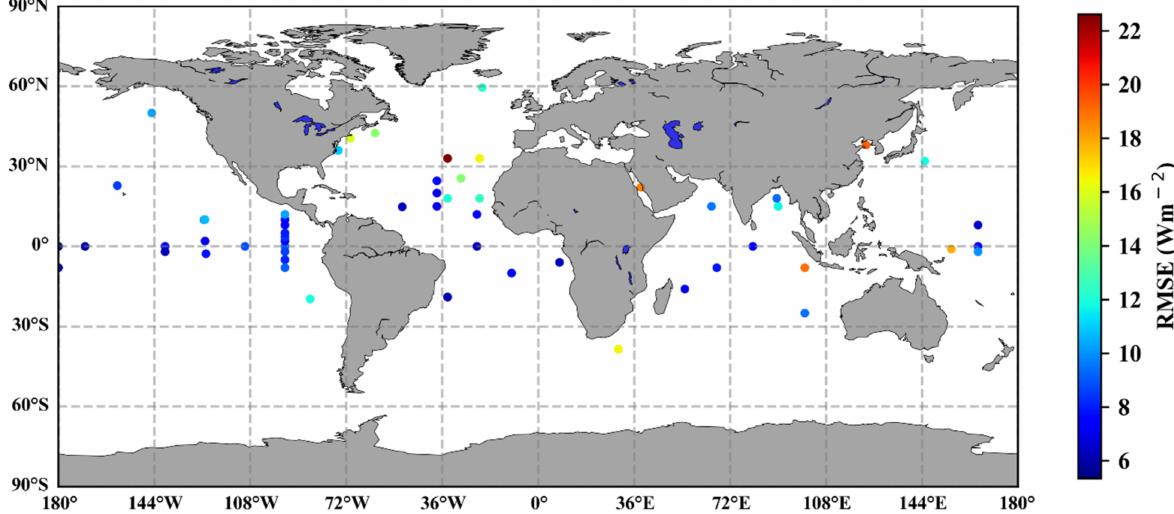
Figure 12. Validation accuracy of the newly developed models at each moored buoy site, represented by the RMSE